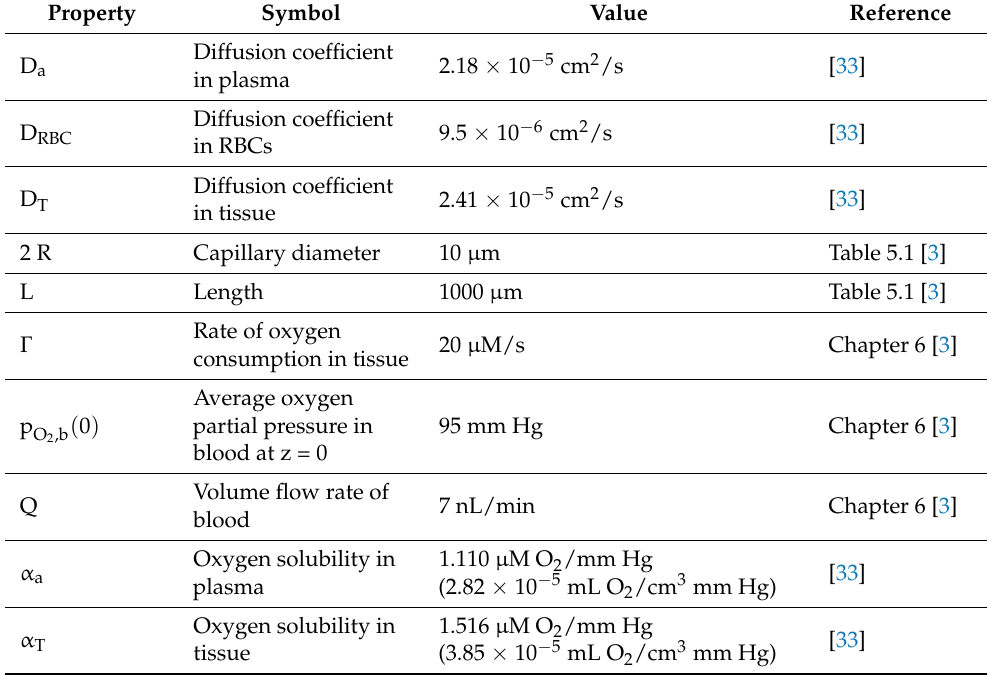
Table 1. Data used for oxygen transport from blood flow in a capillary and comparison with (3).